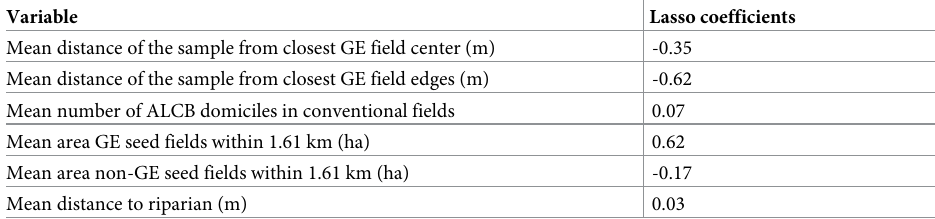
Table 5. Field-level variables explaining gene flow from commercial genetically engineered fields to conventional fields. Lasso coefficients of variables from a lasso methodology transformed proportion of adventitious presence. Variable